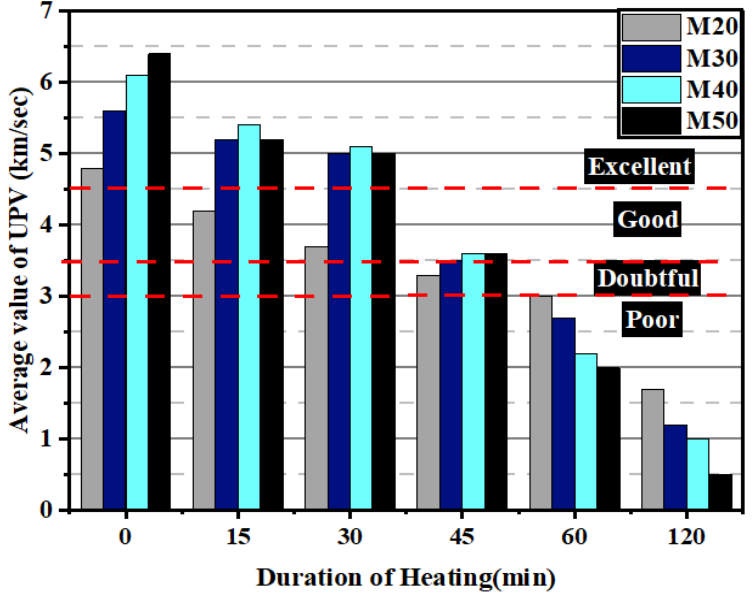
Figure 3. UPV values of M-20 and M-50 concrete specimens following elevated temperature expo- sure.